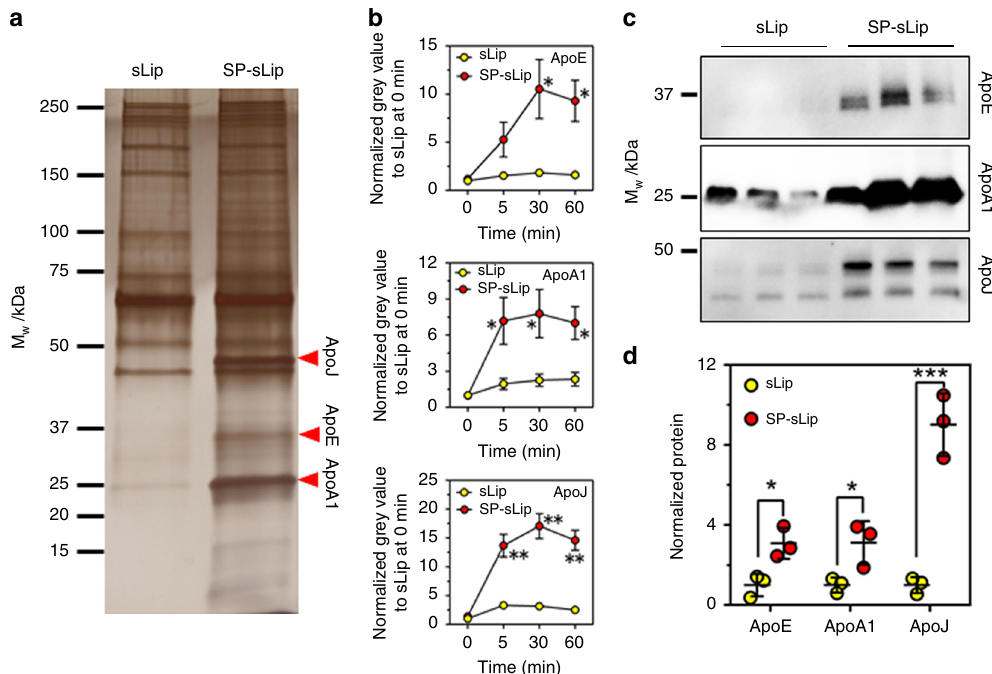
Fig. 2 Characterization of protein coronas in vitro and in vivo. a sLip or SP-sLip were incubated with mouse plasma for 1 h, and the protein coronas were isolated by centrifugation at 14k RCF, separated by SDS-PAGE and stained with silver. b The band intensity of red arrows (ascertained as ApoJ, ApoE, and ApoA1 by nano-LC-MS/MS) was calculated by image J software. The intensity of each apolipoprotein in the formed protein corona on sLip at 0 min was set as 1 for normalization. c , d In vivo absorption of ApoJ, ApoE, and ApoA1 on liposomal surface. DiI-loaded sLip or SP-sLip (100 μ L, DiI 0.4 mg mL − 1 , phospholipid 10 mg mL − 1 ) was injected into BALB/c mice via tail vein. Blood was sampled at 1 h after administration and protein coronas were isolated by centrifugation at 14k RCF. Western Blotting was applied to detect the absorbed ApoJ, ApoE, and ApoA1. Quantitative analysis of proteins was performed by Image J software and the average band intensity of each protein in the formed protein corona on sLip was set as 1 for normalization. Data are means ± SD ( n = 3), and analyzed with GraphPad Prism 6.0. * p < 0.05, ** p < 0.01, *** p < 0.001 by student ’ s t